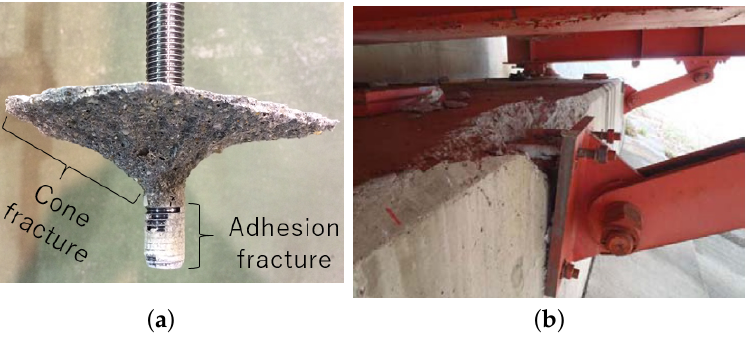
Figure 1. Actual fracture patterns in experiment and structural members. ( a ) Complex fracture pattern shown in anchor bolt pull-out experiment [6]. ( b ) Actual anchor bolt fracture due to the insufficient distance from the edge of the concrete